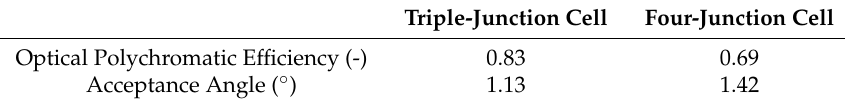
Table 5. Summary of optical polychromatic efficiency and acceptance angle values.